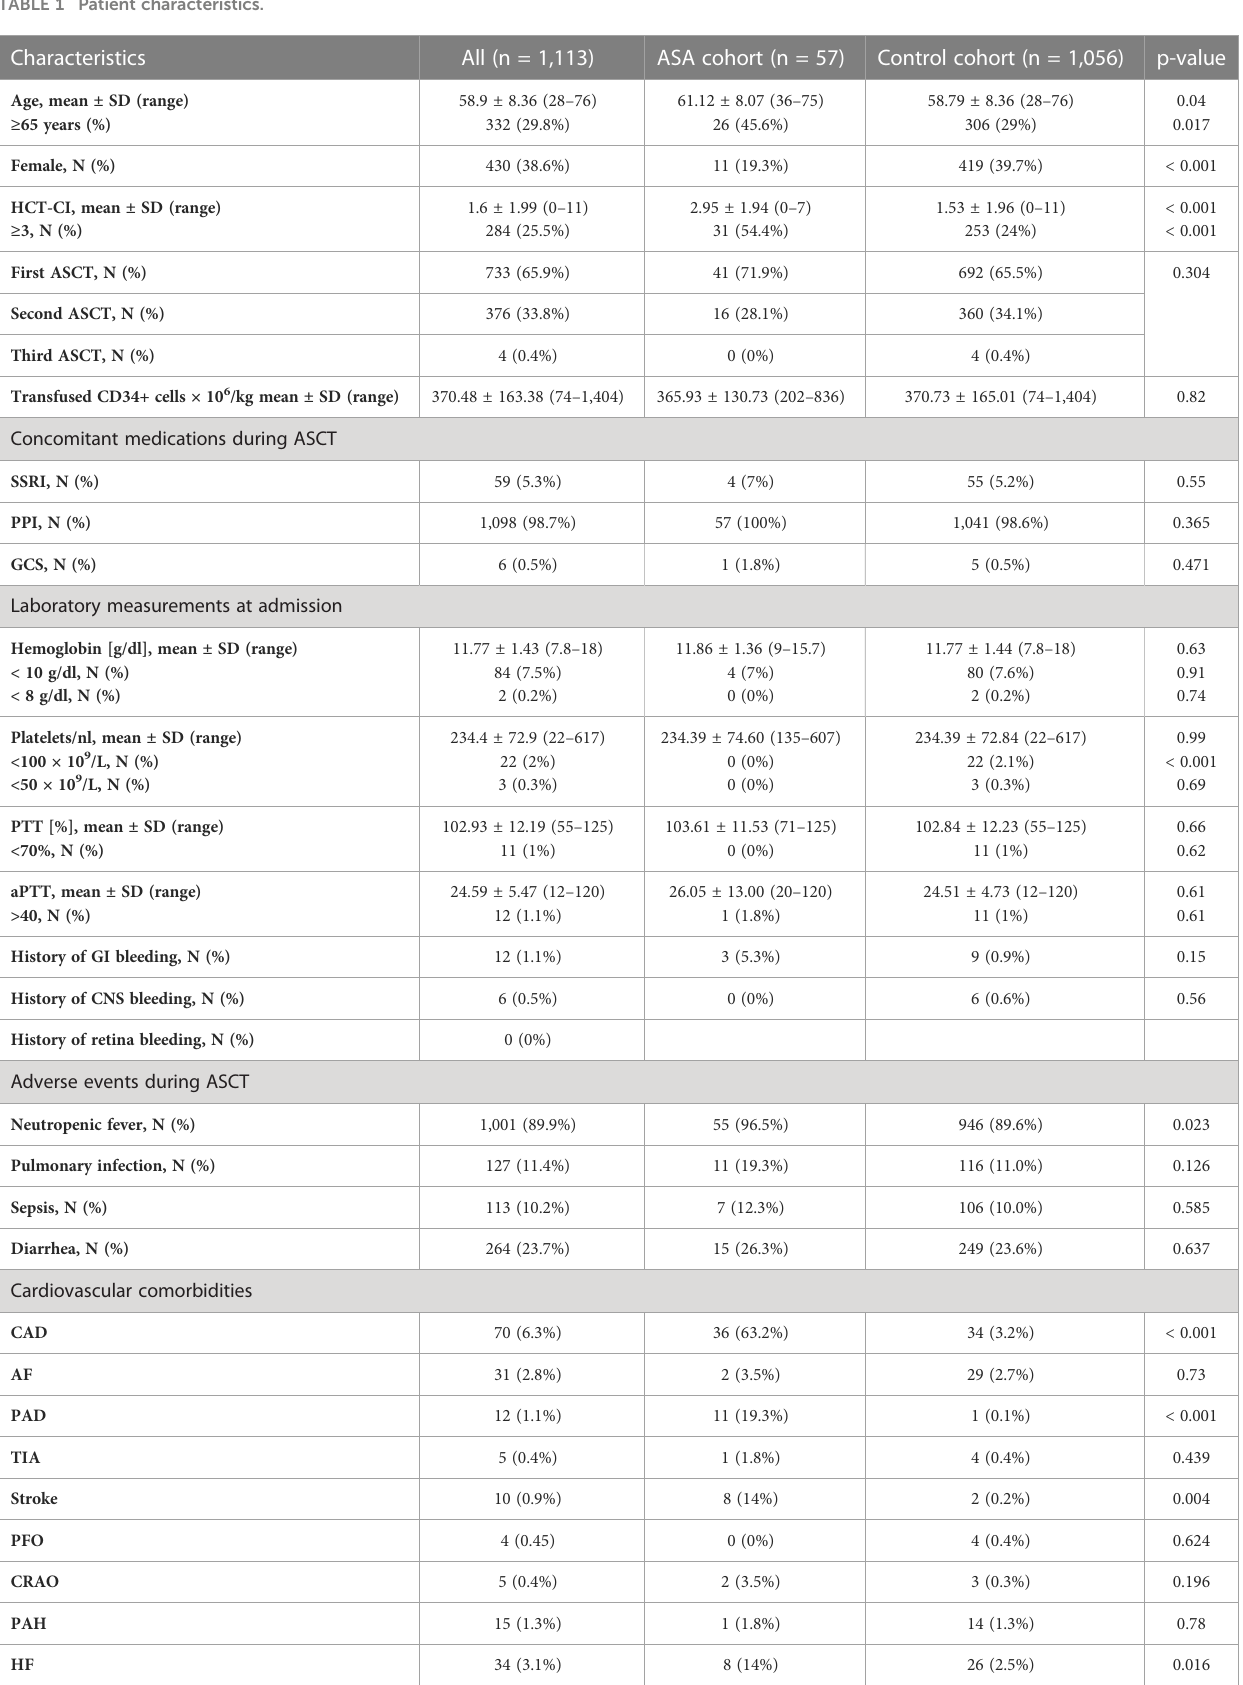
TABLE 1 Patient